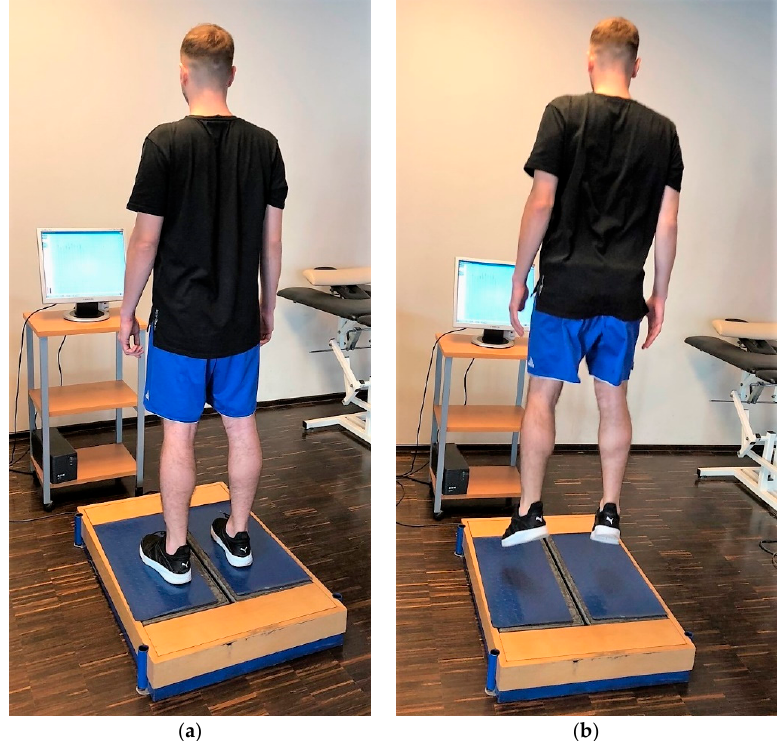
Figure 2. ( a ) The starting position for the vertical ground reaction force (vGRF) measurements during double-leg vertical hops; ( b ) the double-leg vertical hop.